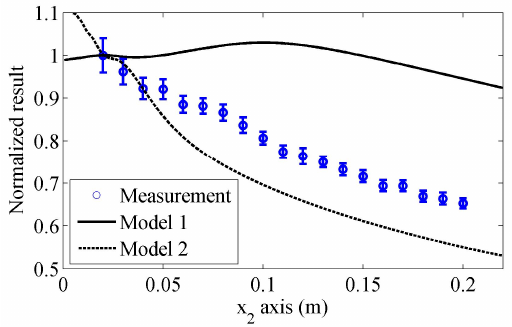
Figure 13. Measured normalized results in the propagation distance and comparisons with the predictions by Model 1 and Model 2.